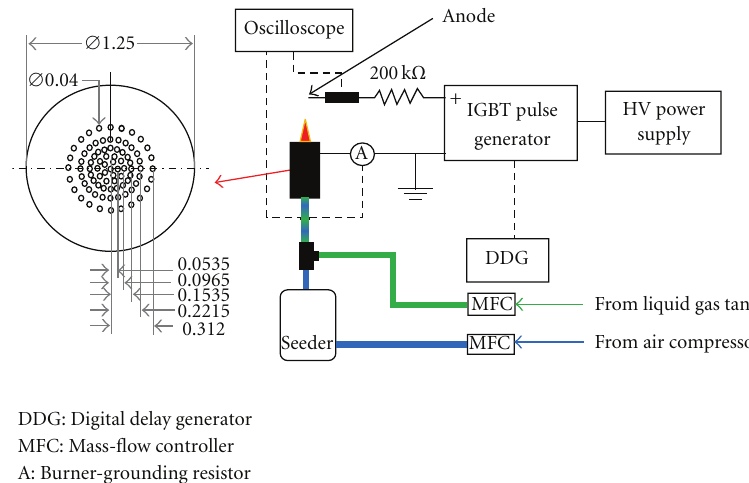
Figure 1: Schematic for millisecond time-scale applied voltage to a premixed flame. The dimensions are in inch.